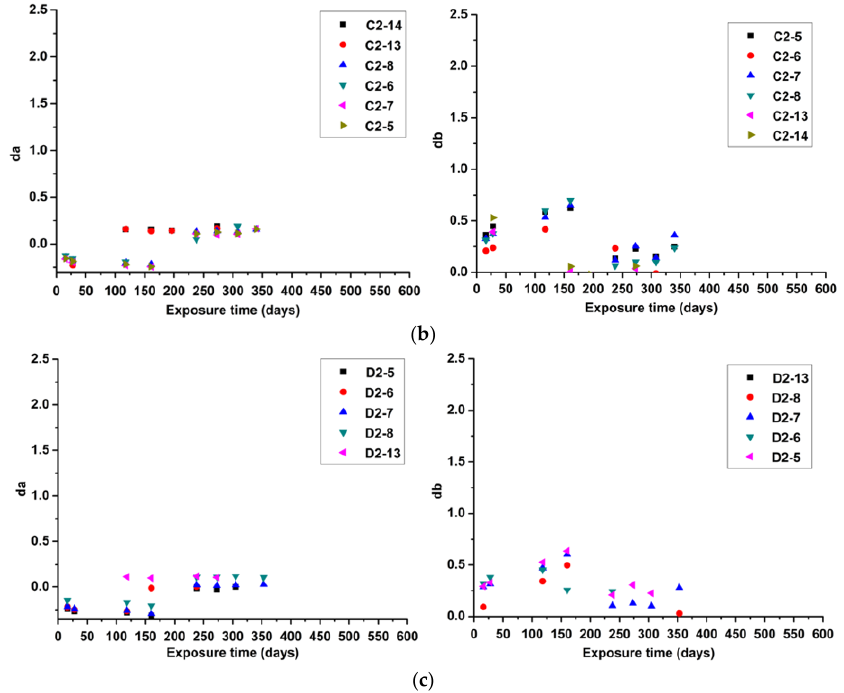
Figure 8. Evolution of color parameters (Δ a and Δ b ) of monolithic mirrors ( a ) A1, ( b ) C2, and ( c ) D2 paint coatings during exposure time at the desert site.